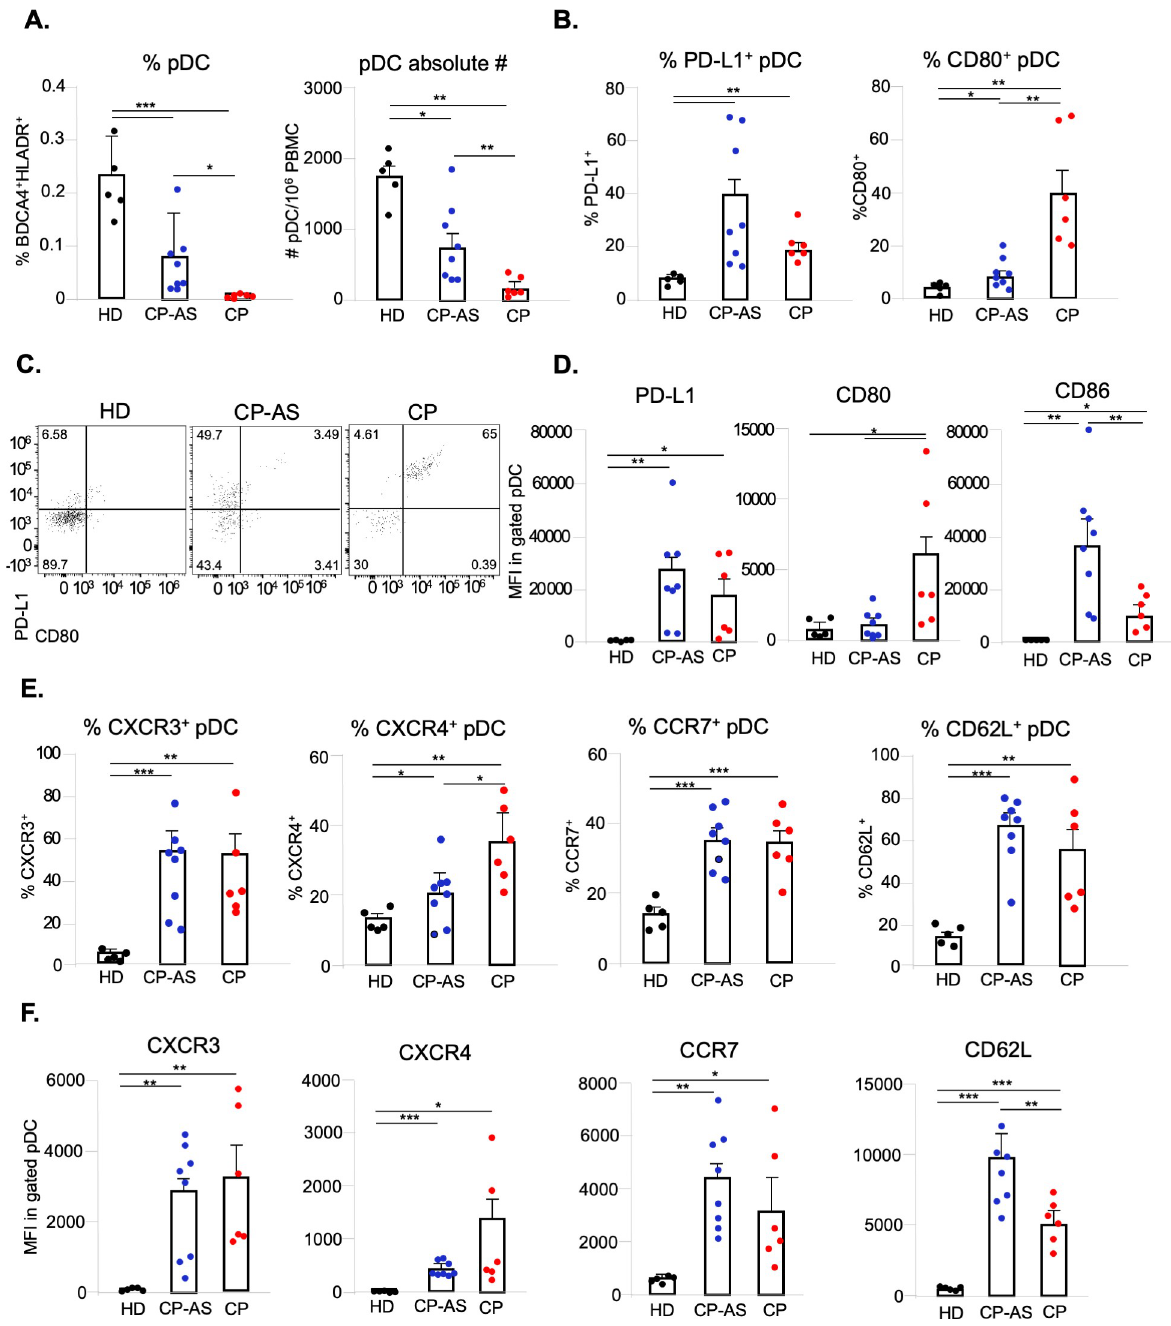
Fig 6. pDC differently activate and express chemokine receptors in COVID-19 asymptomatic and hospitalized patients. Freshly isolated peripheral blood mononuclear cells (PBMC) from asymptomatic (CP-AS, n = 8) and hospitalized COVID-19 patients (CP, n = 6) as well as matched healthy donors (HD, n = 5) were stained with a cocktails of antibodies to study by flow cytometry plasmacytoid dendritic cell (pDC) frequency and absolute number ( A ), diversification and activation status (Lineage, CD123, BDCA-4, HLA-DR, PD-L1, CD80 and CD86) ( B, C, D ), as well as expression of chemokine receptors (CXCR4, CXCR3, CCR7 and CD62-L) ( E, F ). The percentage (%) of shown pDC sub-populations ( B, C, E ) was evaluated in live/single Lineage - CD123 + BDCA4 + HLADR + gated pDC and depicted for each studied patients or HD together with mean ± SEM values. Surface expression of PD-L1, CD80, CD86 ( D ) and CXCR4, CXCR3, CD62-L, CCR7 ( F ), was determined as mean fluorescence intensity (MFI) and shown results were mean relative values ± SEM of analyzed patients or HD. P-values were depicted as follows: � p � 0.05; �� p � 0.001; ��� p � 0.0001.